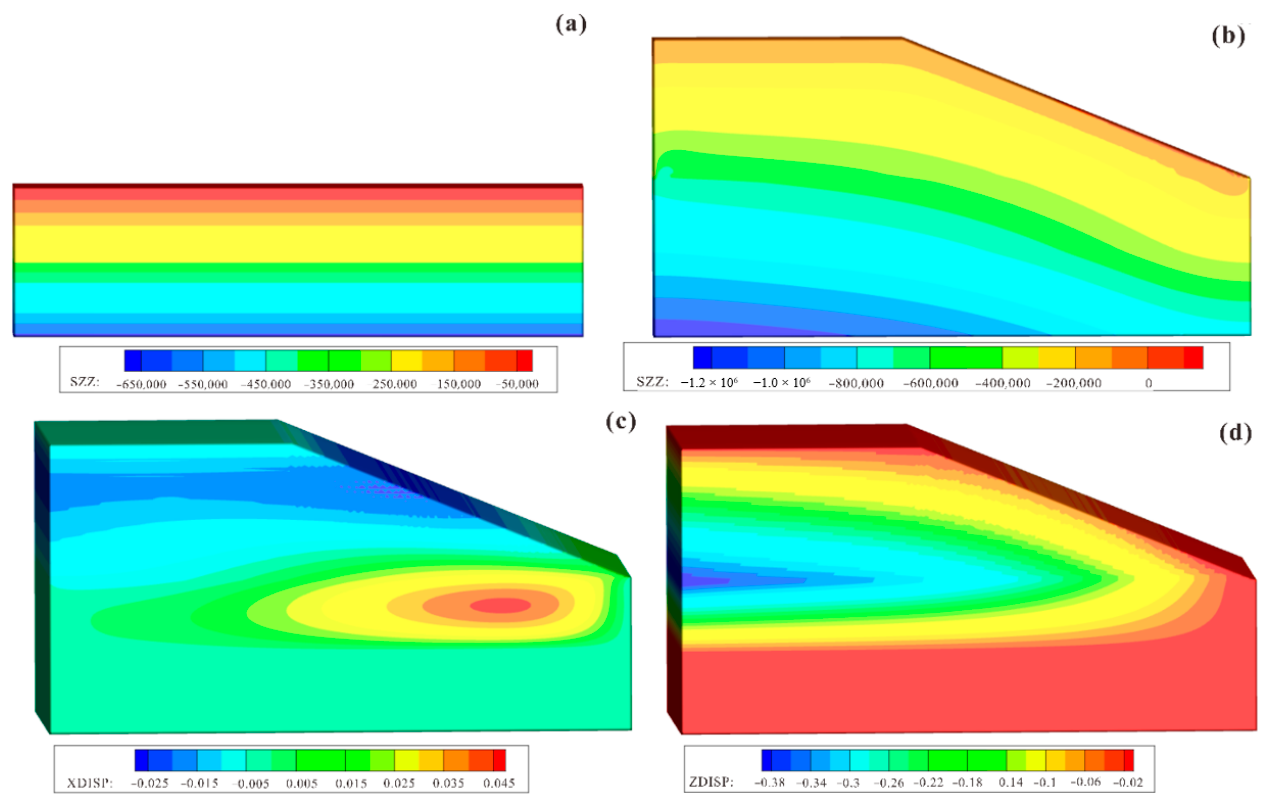
Figure 10. ( a ) Initial strain diagram in the Z direction; ( b ) strain diagram in the Z direction at the end of filling; ( c ) subsidence cloud diagram in the X direction; ( d ) subsidence cloud diagram in the Z direction.